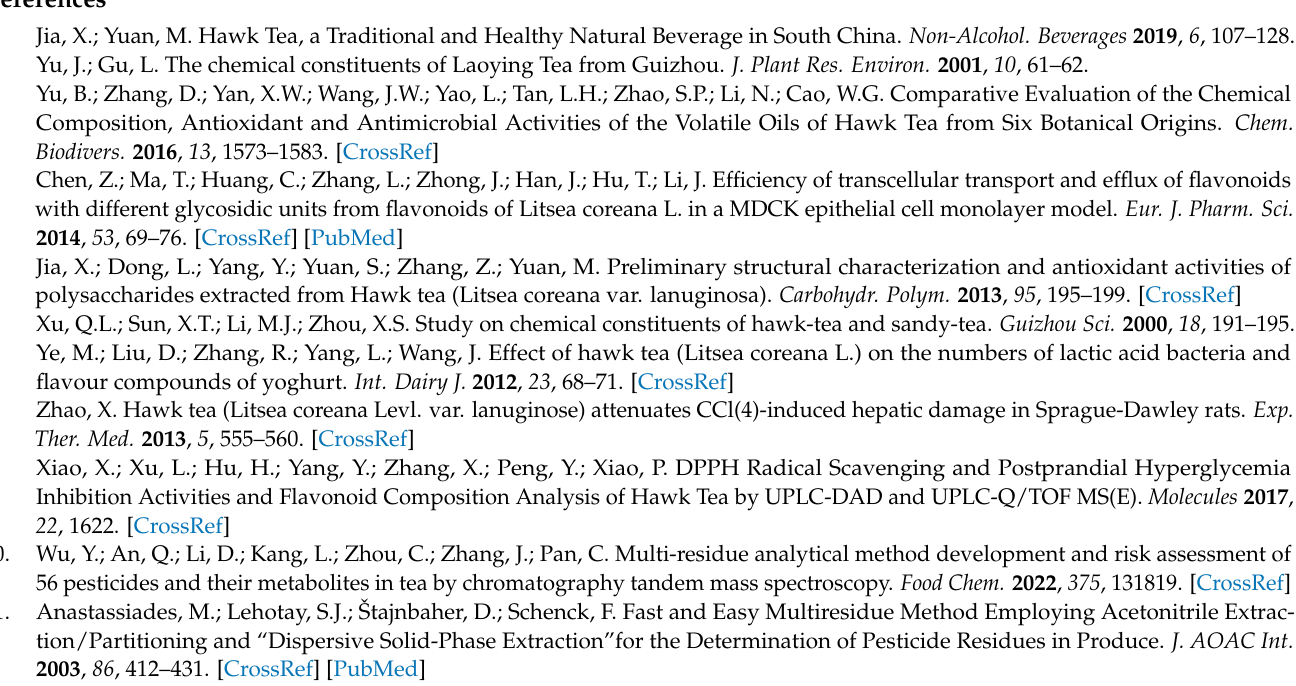
Figure S3: Chromatogram of chlorpyrifos in the mixed solvent of acetonitrile and toluene; Figure S4: Chromatogram of chlorpyrifos in ethyl acetate; Figure S5: The hawk tea blank sample under the Q3scan mode after purification by different materials; Table S1: The major constituents of hawk tea processed by different methods; Table S2: The comparison of different adsorbent combination on recoveries and RSDs for 186